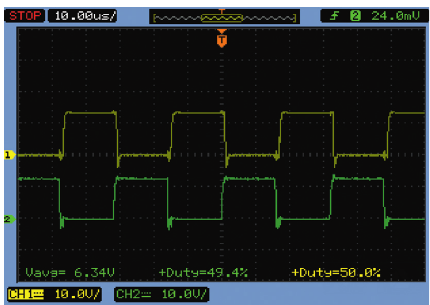
Figure 2: The PWM signals monitoring the switches M